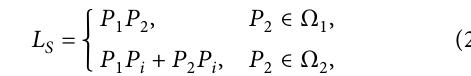
Figure 3: The division of the space outside the detection range.